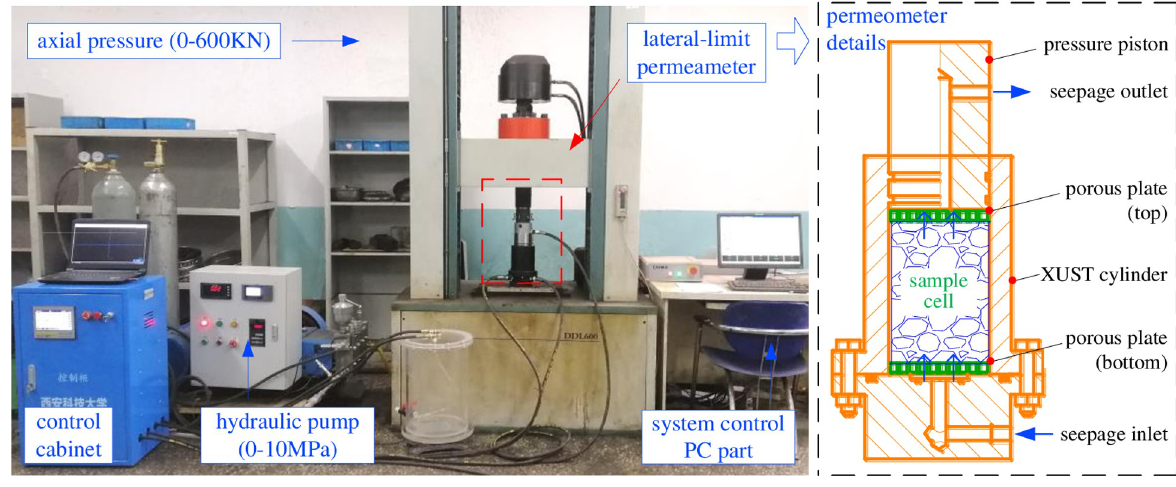
Fig 3. Sample installation